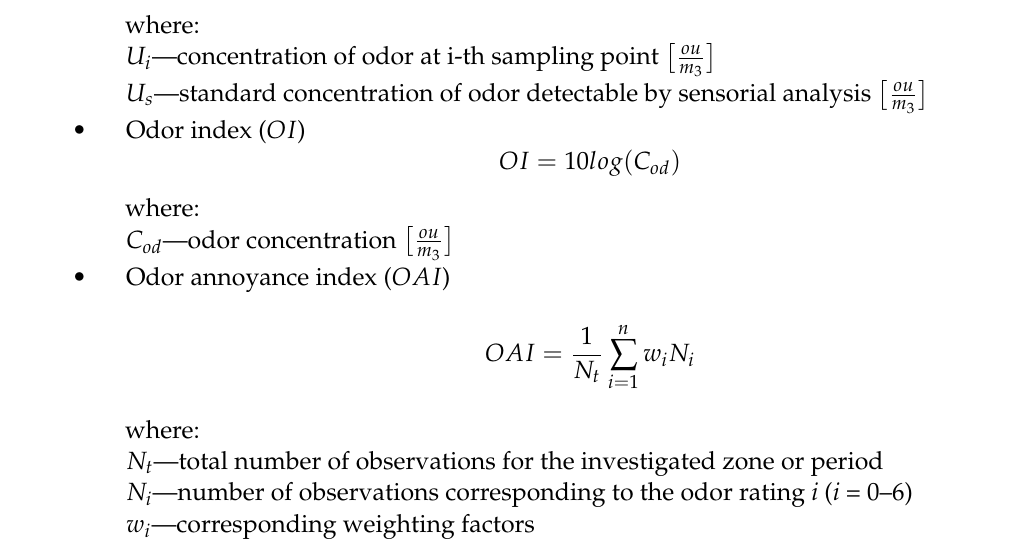
Table 2 provides examples of industrial and municipal facilities for which an odor nuisance assessment was conducted using the indicators listed above. Table 2. Indicators and indexes used for evaluation of odor nuisance of exemplary industrial and municipal